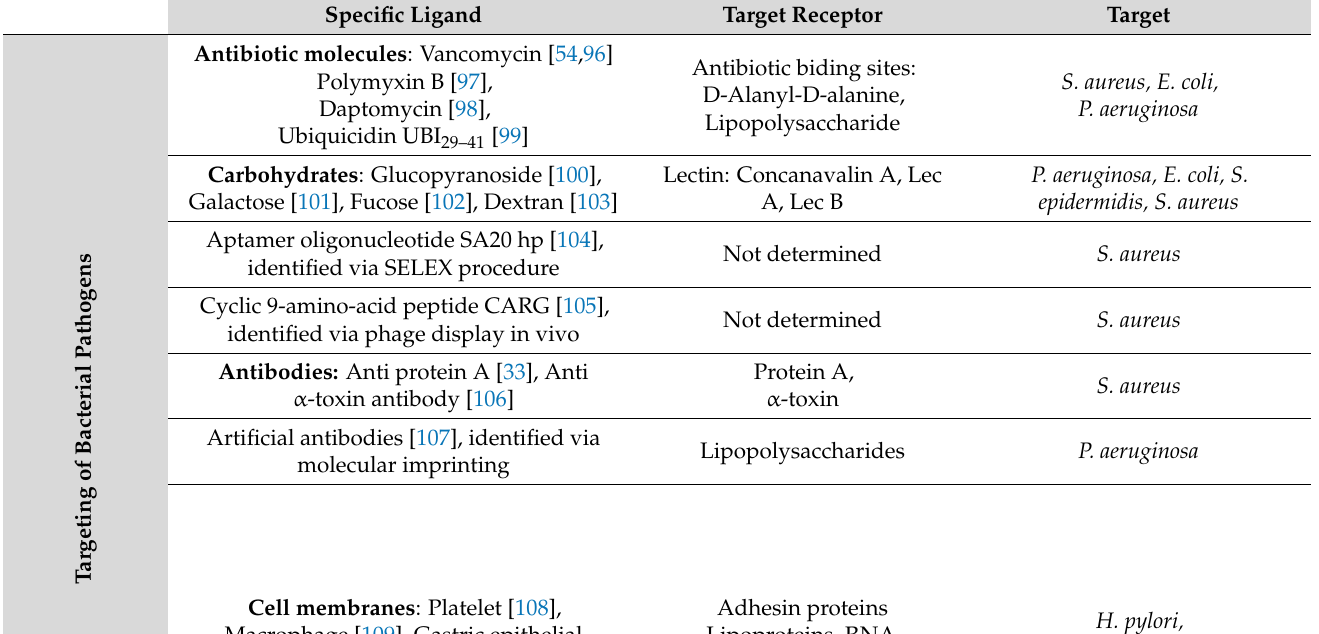
Table 3. Receptors and corresponding ligands for active targeting of antibiotic delivery systems. Specific Ligand Target